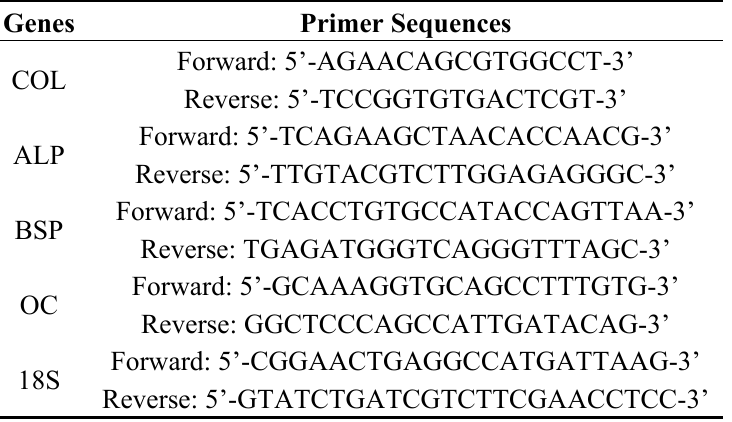
Table 1. Primer pairs used in the